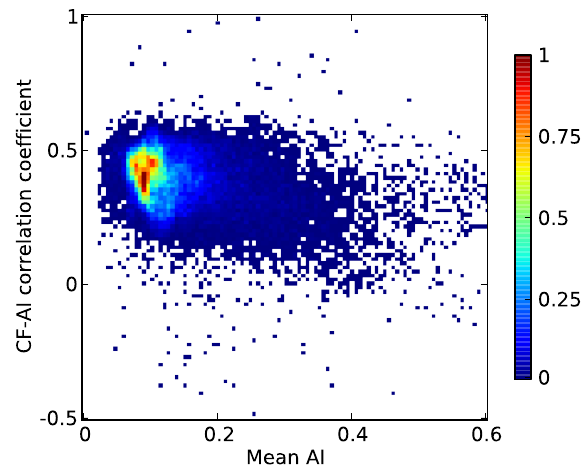
Figure 10. Joint histogram of the AI–CF correlation in the study region as a function of local mean AI, using Terra MODIS data at 1 ◦ by 1 ◦ resolution over the period 2003–2011. The histogram is normalised by the maximum frequency of